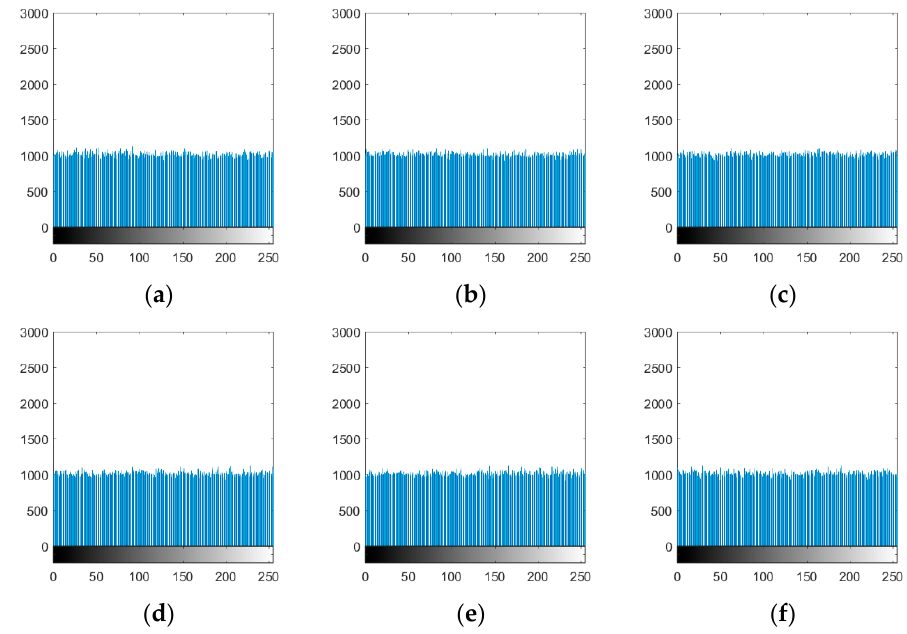
Figure 7. Histograms of the encrypted image. ( a ) Airplane; ( b ) Baboon; ( c ) Barbara; ( d ) Lena; ( e ) Peppers; ( f ) Zelda.